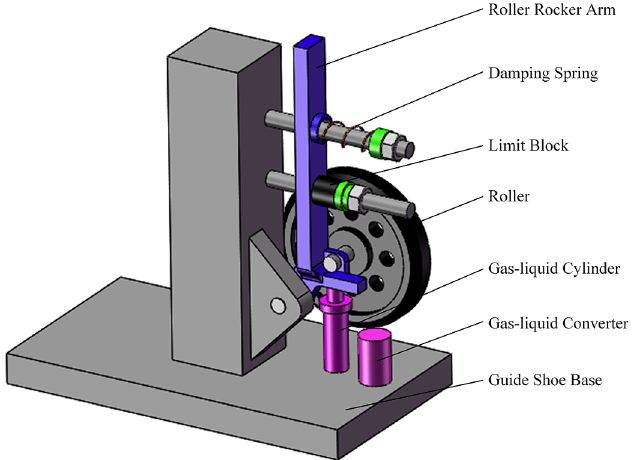
Fig. 1. Schematic of the gas – liquid active guide shoe.